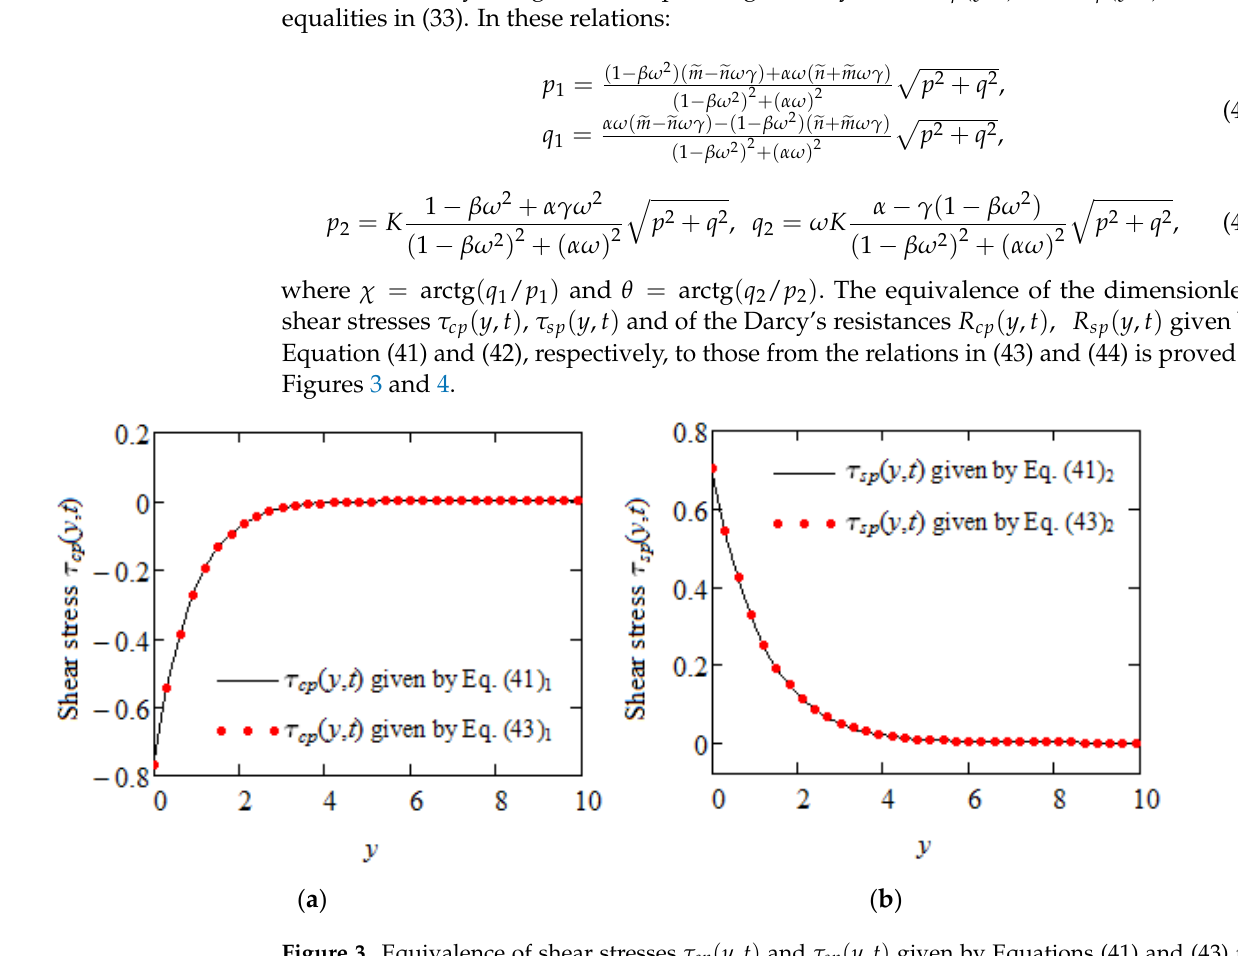
Figure 3. Equivalence of shear stresses τ cp ( y , t ) and τ sp ( y , t ) given by Equations (41) and (43) for α = 0.8, β = 0.7, γ = 0.6, ω = π /12, M = 0.6, K = 0.4, K ef f = 1, and t = 10.